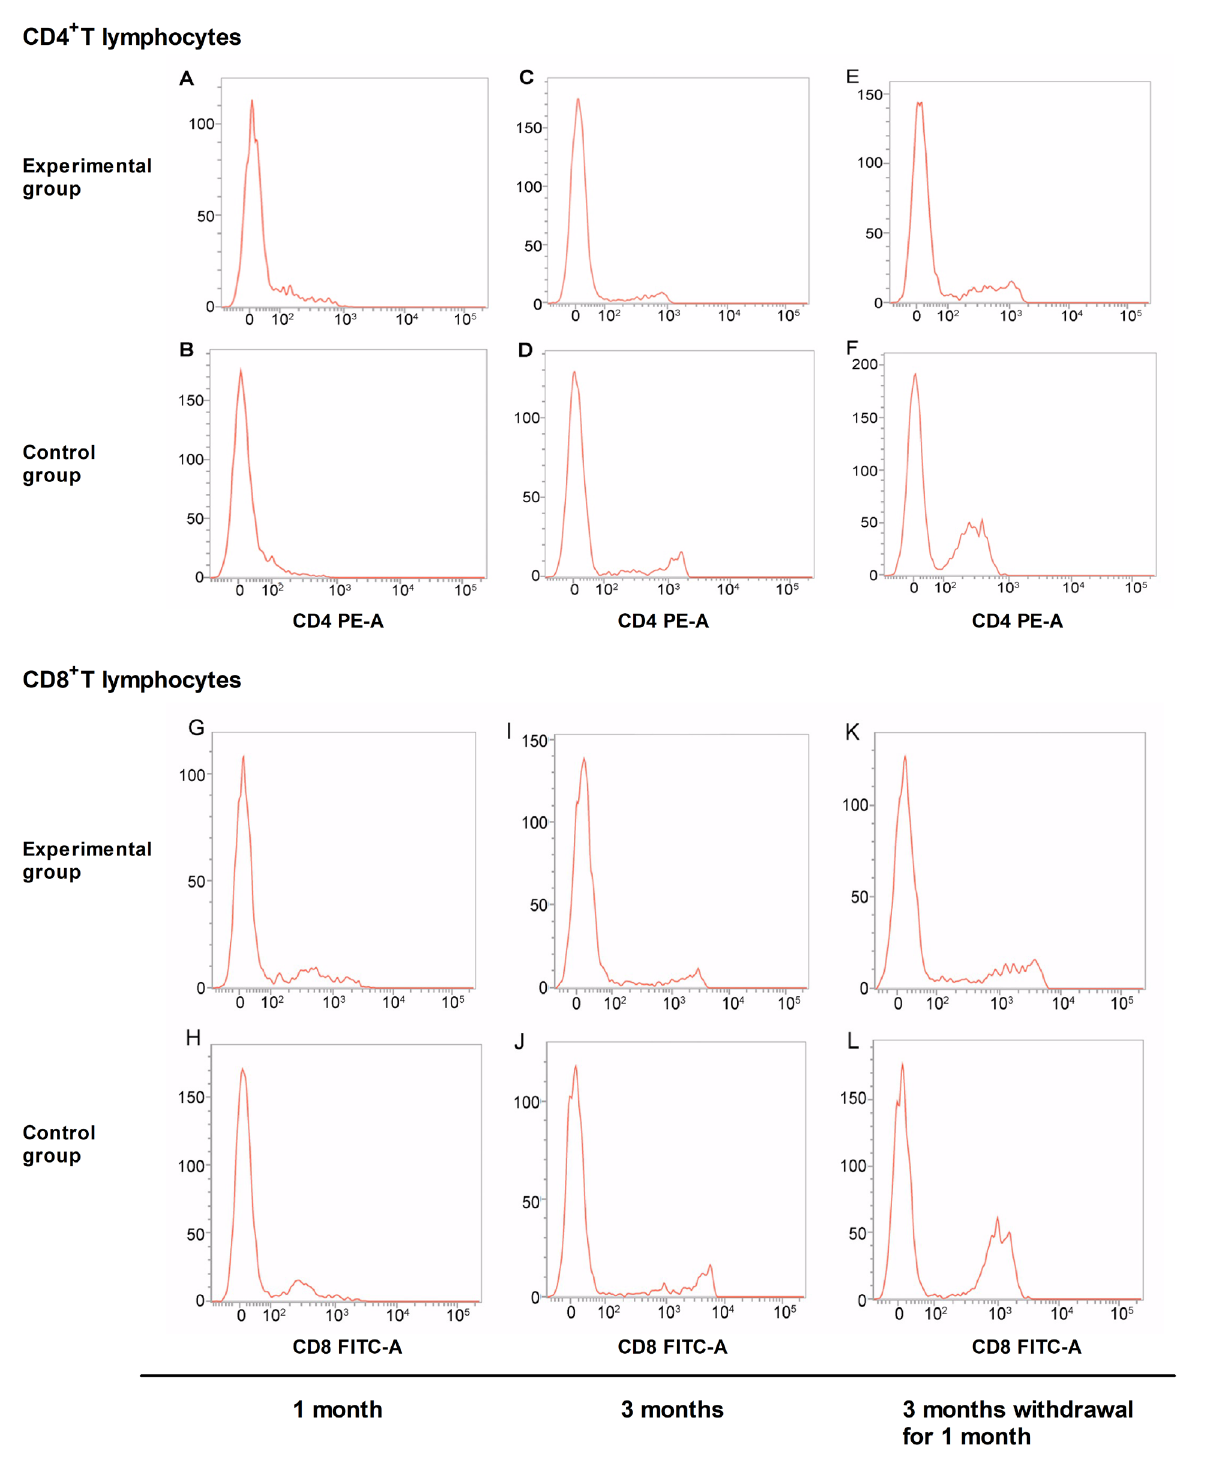
FIGURE 1 - CD4 + T lymphocytes in (A) experimental group after drug feeding for 1 month, (B) control group after drug feeding for 1 month, (C) experimental group after drug feeding for 3 months, (D) control group after drug feeding for 3 months, (E) experimental group after drug feeding for 3 months followed by drug withdrawal for 1 month, (F) control group after drug feeding for 3 months followed by drug withdrawal for 1 month. CD8 + T lymphocytes in (G) experimental group after drug feeding for 1 month, (H) control group after drug feeding for 1 month, (I) experimental group after drug feeding for 3 months, (J) control group after drug feeding for 3 months, (K) experimental group after drug feeding for 3 months followed by drug withdrawal for 1 month, (L) control group after drug feeding for 3 months followed by drug withdrawal for 1